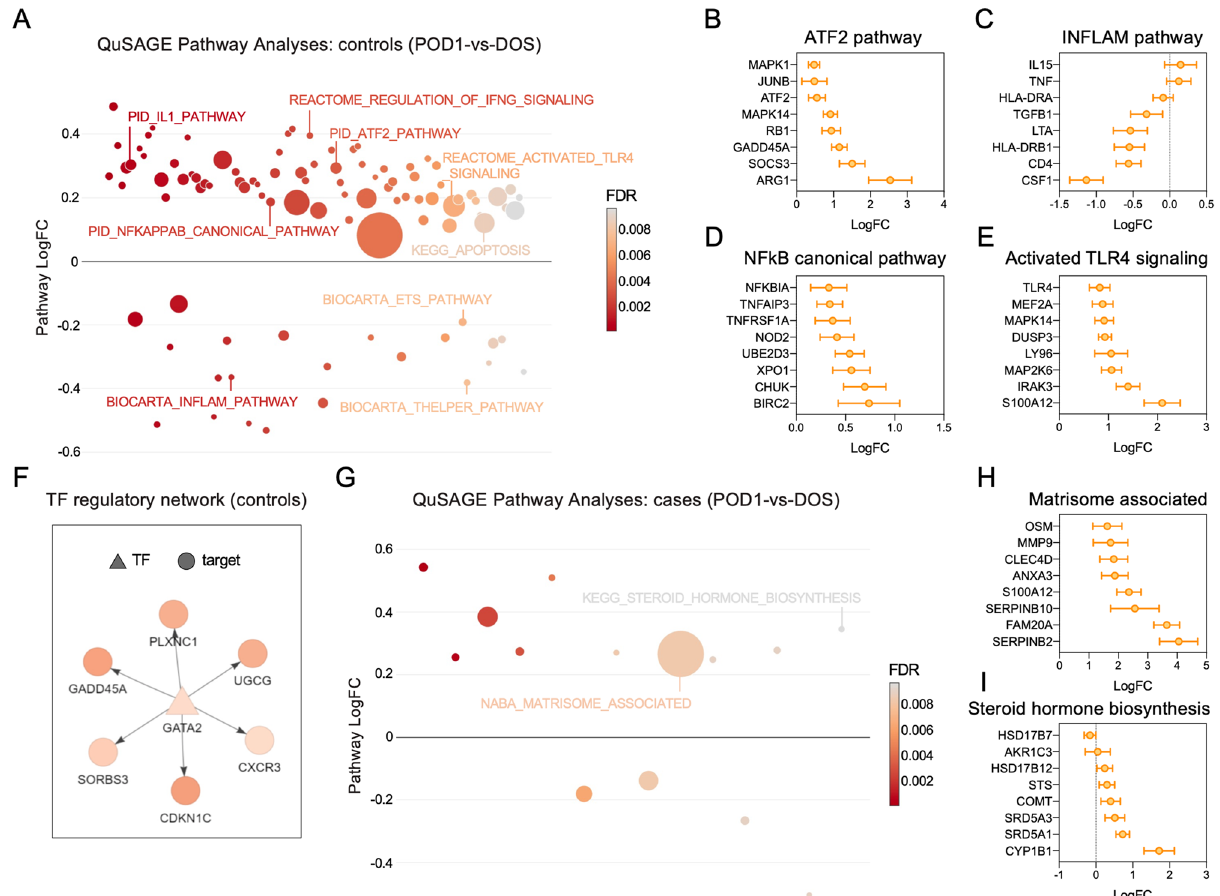
Figure 5. Functional analyses of the differentially expressed genes identified by RNA-seq in PAXgene blood RNA in cases (stiff knees) and controls. ( A ) Representation of the QuSAGE pathway analyses at 24 h after surgery (POD1) relative to the day of surgery (DOS) in control patients (N = 10) showing functional pathways differentially expressed at POD1 vs. DOS (FDR < 0.01). Representative genes associated with the ( B ) ATF2, ( C ) INFLAM, ( D ) canonical NF-κB signaling, and ( E ) activated TLR4 signaling pathways are shown, representing changes in gene expression (logFC) in POD1 vs. DOS for the controls. ( F ) Transcription factor